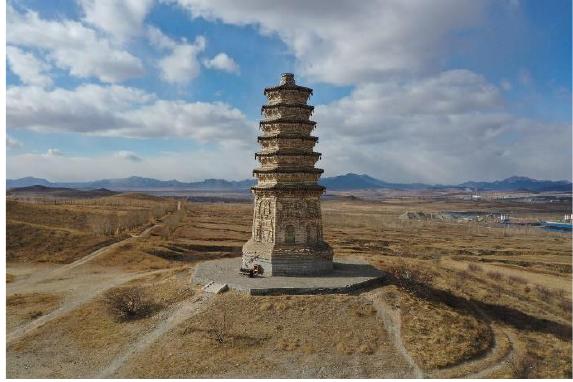
Figure 8. the South Tower of Liaoshangjing Site